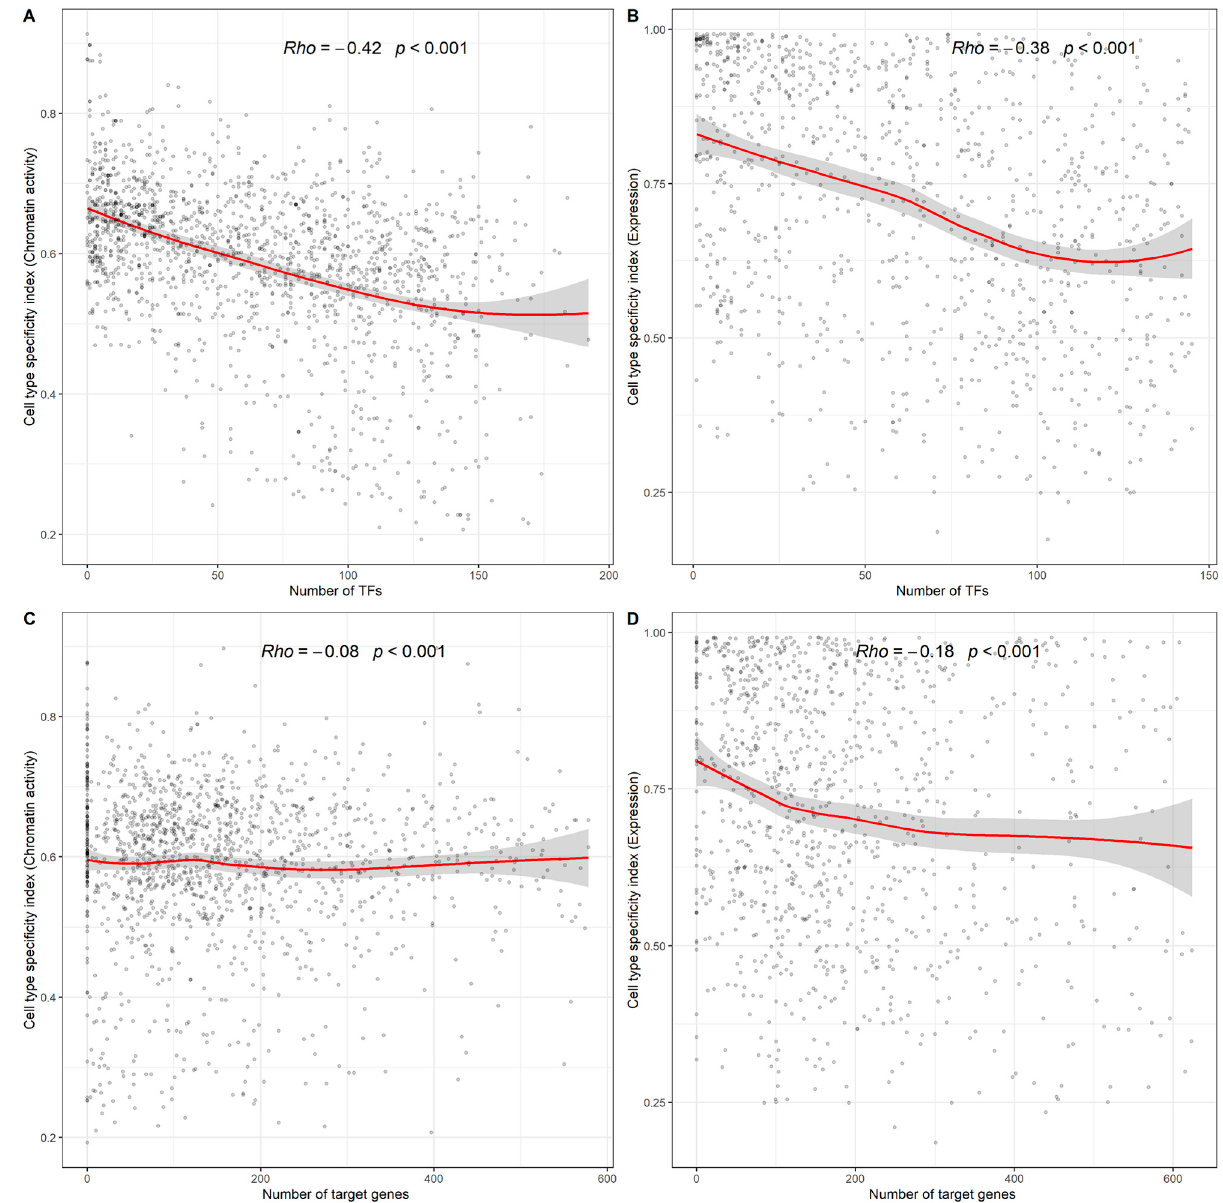
Figure 2. Correlation of cell type specificity of miRNAs with the numbers of regulating TFs and target genes. ( A ) Correlations between cell type chromatin activity specificity index and the number regulating of TFs. ( B ) Correlations between cell type expression specificity index and the number of regulating TFs. ( C ) Correlations between cell type chromatin activity specificity index and the number regulating of target genes. ( D ) Correlations between cell type expression specificity index and the number of regulating target